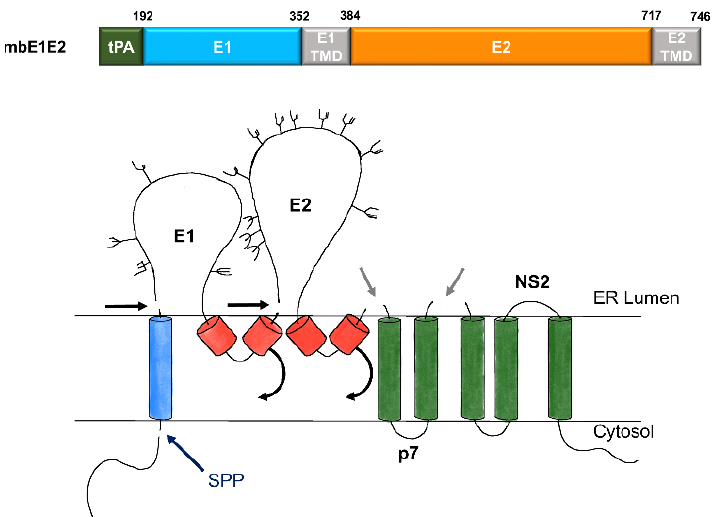
Figure 2. Expression and processing of mbE1E2. (top) Schematic of the E1E2 signal peptide (SP) plus polyprotein expression construct. (bottom) Processing pathway for the N-terminal portion of the HCV polyprotein. Signal peptidase cleavages release E1 and E2 (black and gray arrows). Signal peptide peptidase (SPP) cleavage of HCV core is indicated by a dark blue arrow. Repositioning of E1 and E2 transmembrane domains (TMDs) is indicated by curved arrows. Glycans attached to E1 and E2 are depicted as branched structures. Adapted from [74].